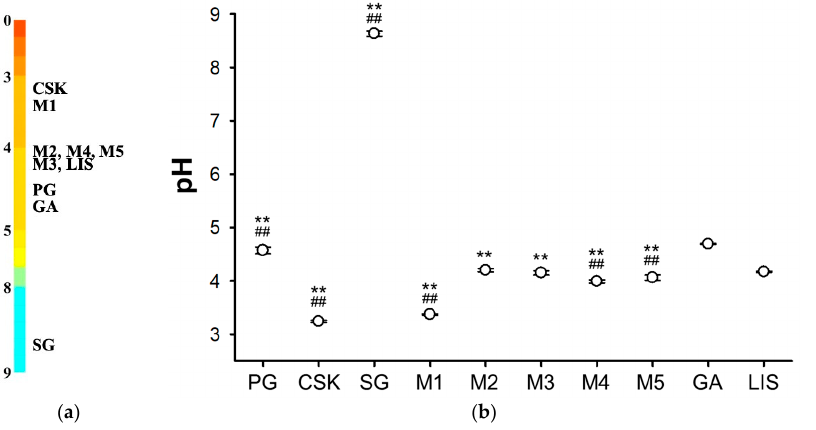
Figure 1. pH statistical quantitative value. All experimental groups were compared to Garglin Original™ (GA) and Listerine Cool Mint Antiseptic™ (LIS). ( a ) Schematic drawing for each